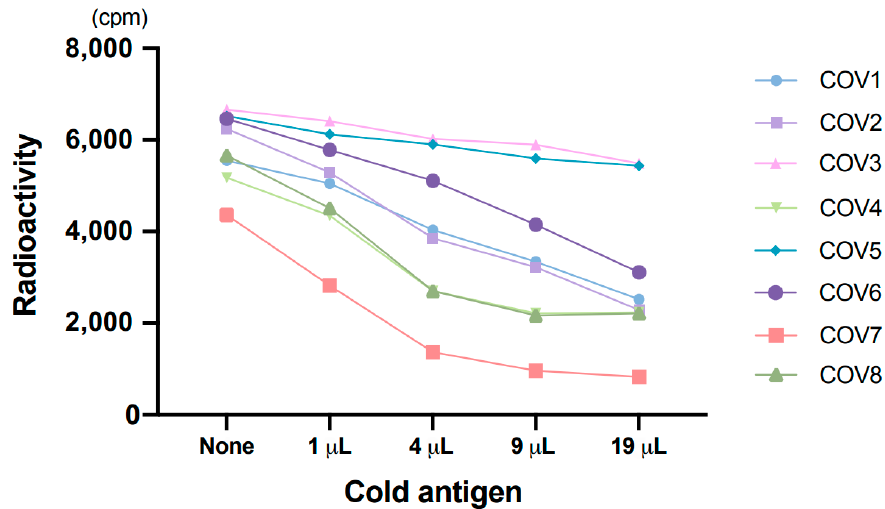
Figure 3. Absorption test. Non-radiolabeled (cold) antigens were used to absorb specific antibod- ies.